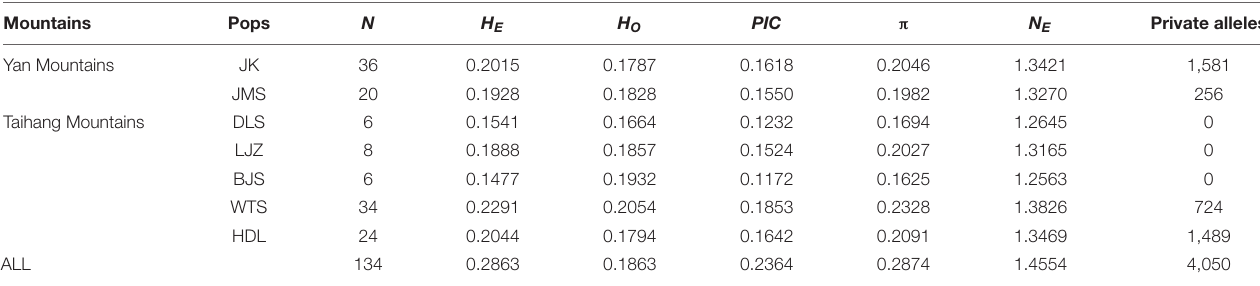
TABLE 1 | The statistics of the number of samples ( N ), expected heterozygosity ( H E ), observed heterozygosity ( H O ), polymorphism information content ( PIC ), nucleotide diversity ( π ), efficient allelic number ( N E ), and the number of private alleles among populations (Pops). Mountains Pops N H E H O PIC π N E Private alleles Yan Mountains JK 36